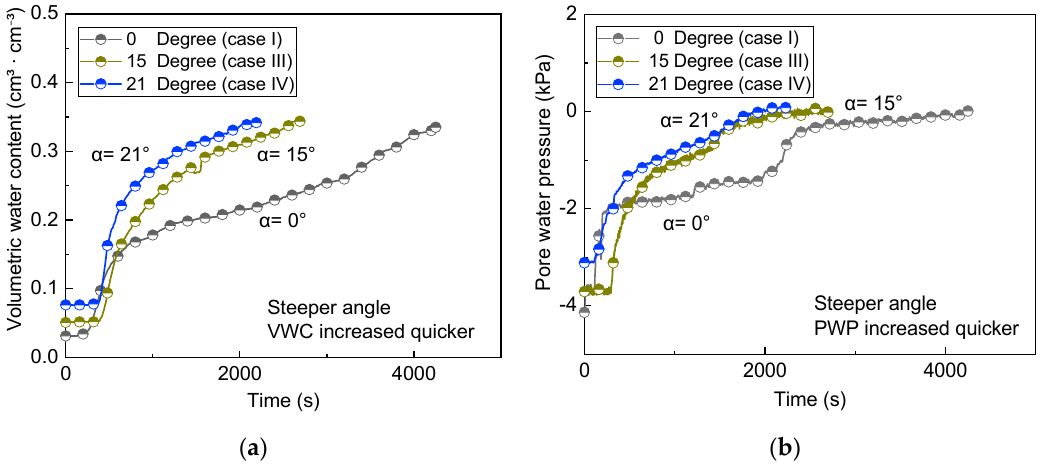
Figure 15. Time series of the VWC and pore pressure at the bottom of the slope for case I, III, and IV, with α ranging from 0° to 21° (multi-layer slope). ( a ) Time series of the VWC from initiation to failure; ( b ) time series of the pore pressure from initiation to failure.